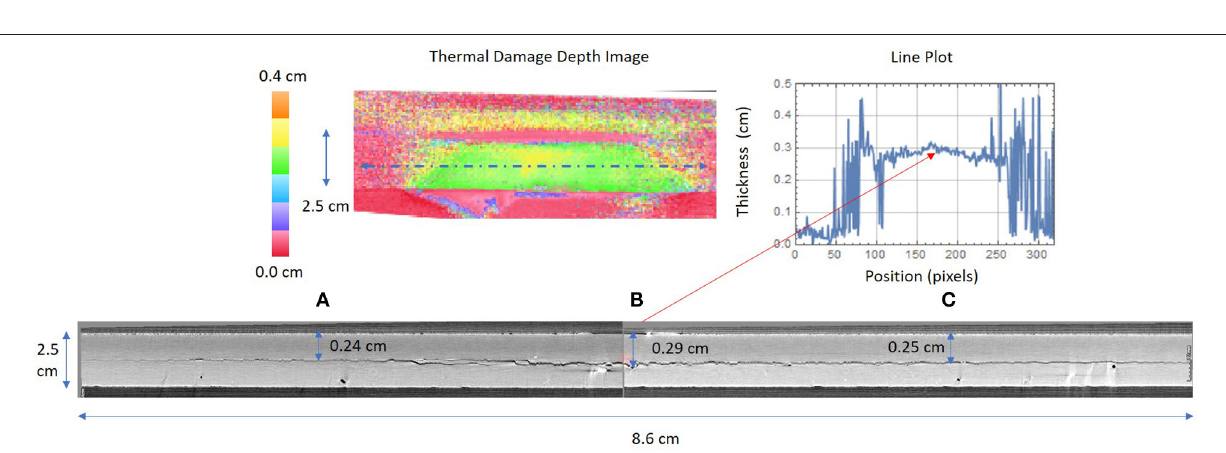
FIGURE 14 | Thermal damage depth image and line plot for large delamination with comparison to X-ray CT cross section slice. At three different locations (A–C)